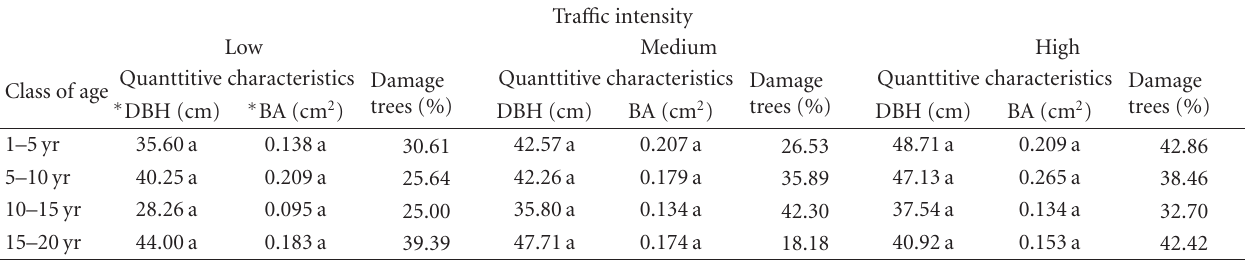
Table 3: General measurement of some characteristics of remaining trees in each abandoned skid trail.